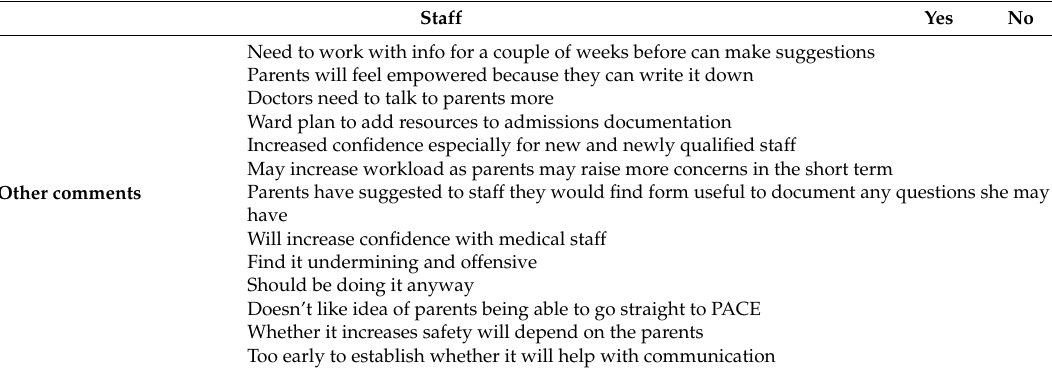
Table 2. Evaluation